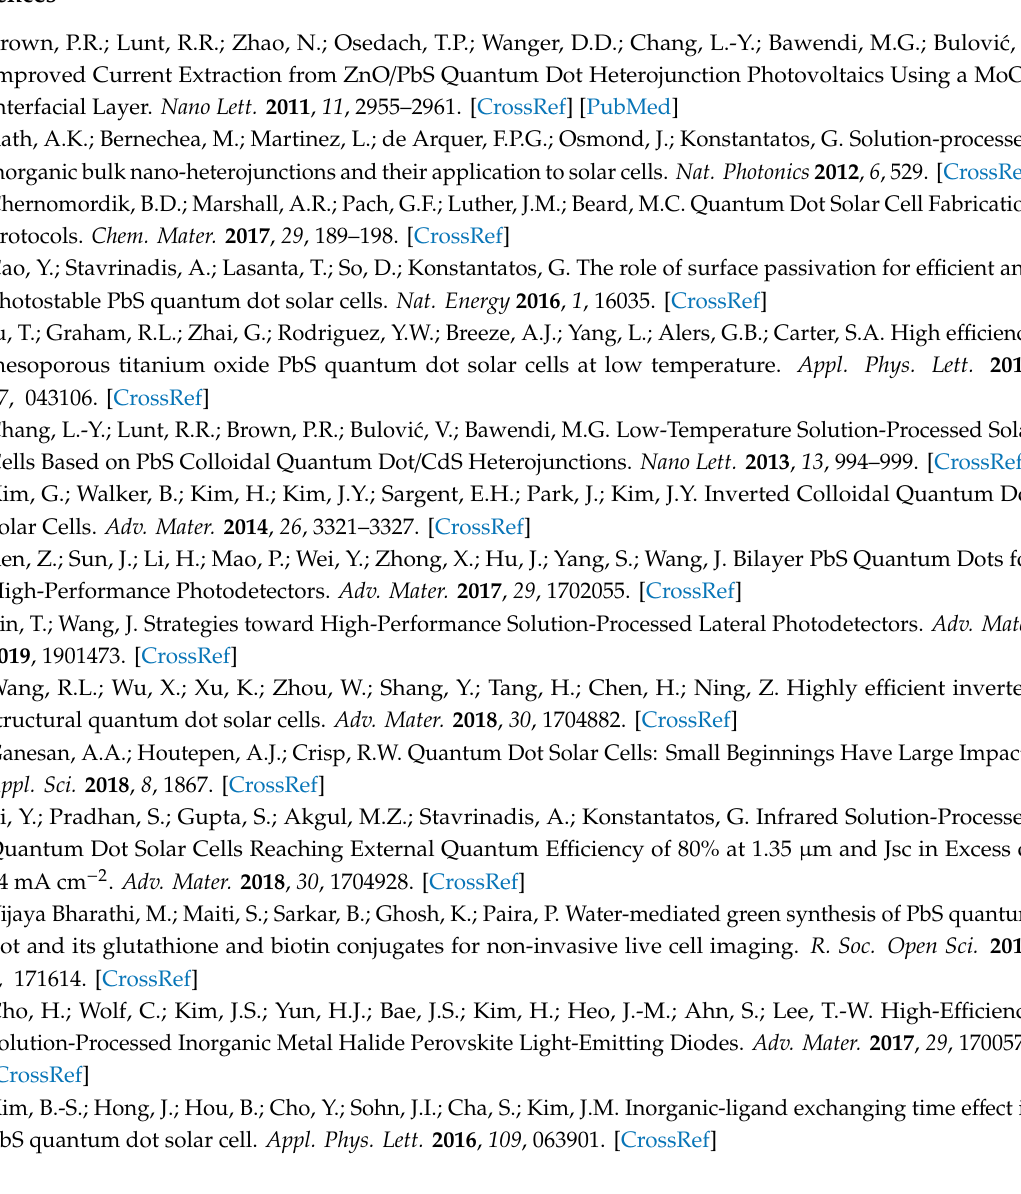
Figure S1: EQE spectra for the simulated results for our device, Figure S2: a. One layer of spin-coated film surface has many pinholes b. Four layers of spin-coated film surface has no pinhole, Figure S3: a. Ag electrode causes crack on the surface b. Cr-Ag electrode causes no crack on surface after five